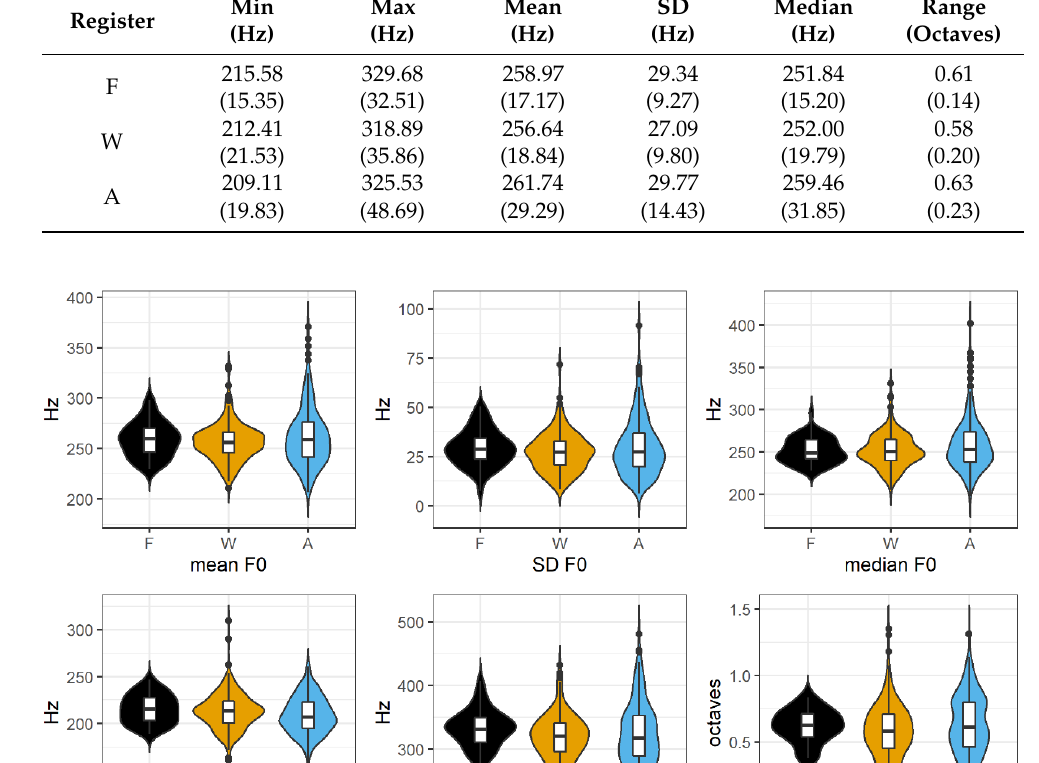
nificant differences found in measures of F0 variation across registers were between W and A: median F0 is lower in W than A ( β = −7 .458; SE = 2.589; t = −2 .88; p = 0.0042); mean F0 is lower in W than A ( β = −5 .106; SE = 2.427; t = −2 .104; p = 0.036); SD of F0 is lower in W than A ( β = −2 .674; SE = 1.22; t = −2 .188; p = 0.029); F0 range in octaves is narrower in W than A ( β = −0 .0432; SE = 0.021; t = −2 .034; p = 0.043). There were no significant differences in measures of F0 variation between W and F. The overall similar range of F0 variation across registers is perhaps to be expected as these are data from a single speaker and thus reflect her individual pitch range. The ob- served differences indicate greater use of higher and/or more expanded pitch by speaker f2 in A than W. The distribution of F0 range values is slightly bimodal in the A register, indicating a split which is also visible to a lesser extent in the distribution of values of max F0 in the A register. This split reflects the fact that f2 produced a subset of A-coded turns in a much wider pitch range, which have the auditory impression of being ‘performed’, as an example for the interlocutor of how an utterance would be produced naturally in context between SA speakers. Figure 4 shows an example in which f2 provides a sample of how a SA lexical item ([ ˈɡ awħaza] ‘to sit’) would be used; the reporting clause (‘And she says:’, coded W) is produced in a relatively narrow pitch span (0.5 octaves), but the reported clause (coded A) is produced in a very wide pitch span (1.3 octaves).